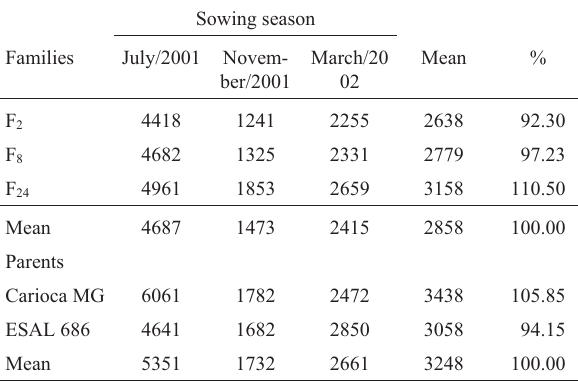
Table 2 - Average of grain yield means (kg/ha) of the F 2 , F 8 and F 24 derived families and the parents in three sowing seasons July/2001, November/2001 and